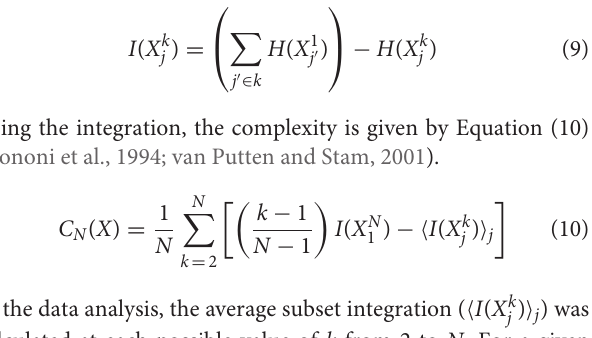
Frontiers in Physiology |